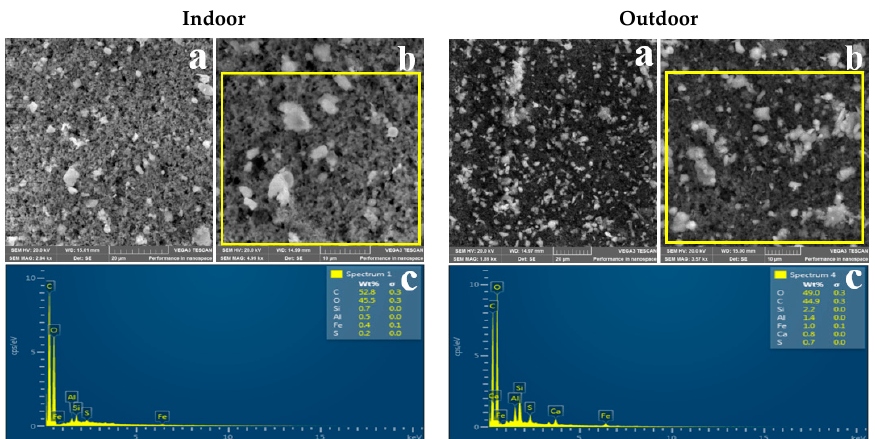
Figure 2. SEM images of indoor and outdoor PM 2.5 sampled at Old Sicelo: ( a ) image captured at 20 µm; ( b ) image captured at 10 µm; ( c ) EDS spectrum of the portion highlighted in yellow. Indoor Outdoor Indoor Outdoor